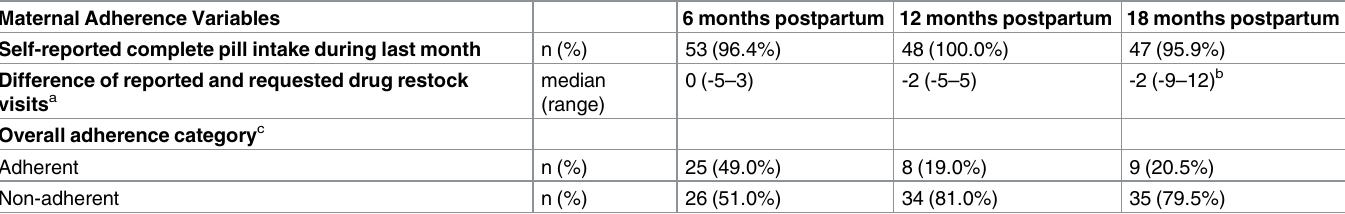
Table 2. Maternal adherence at different study visits.